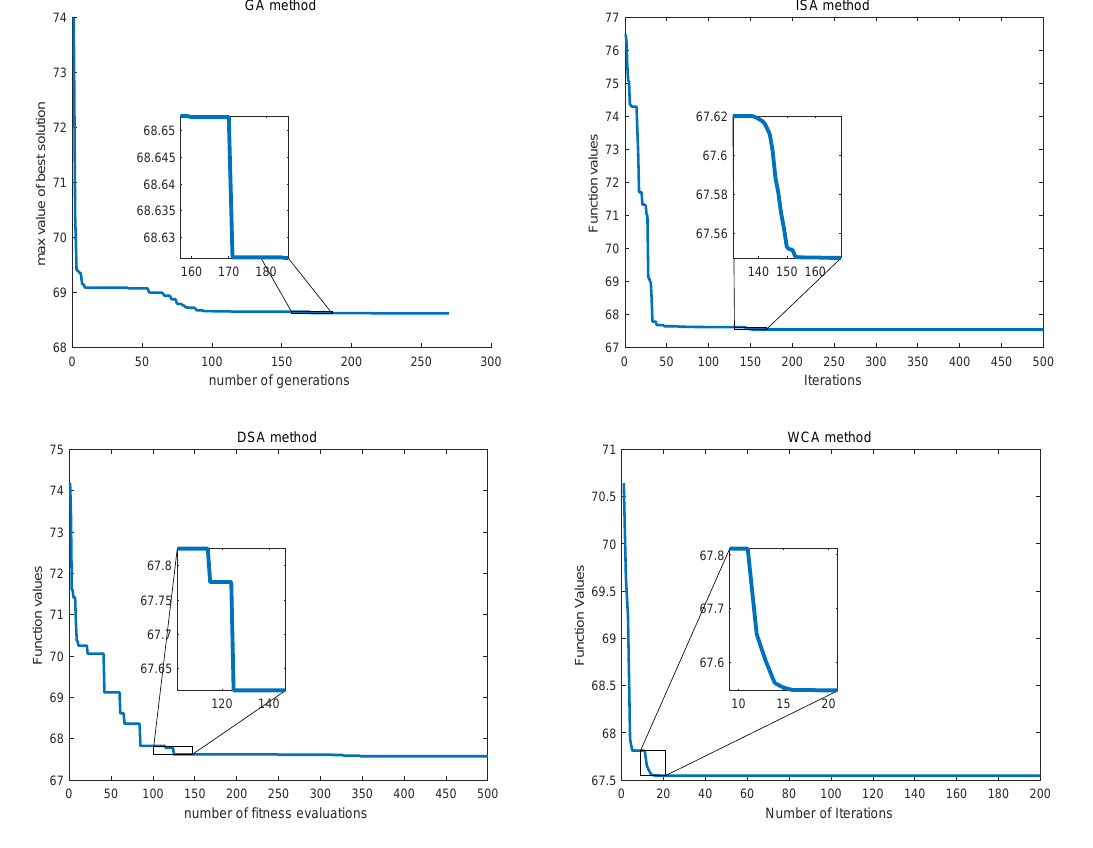
Figure 8. The generation cost at time 1